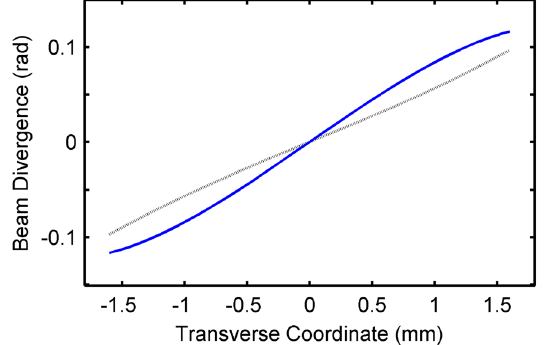
FIG. 14. Phase-space of a beam of straight rays (dotted black) and a realistic beam (solid blue) at z ¼ 3 . 5 mm.